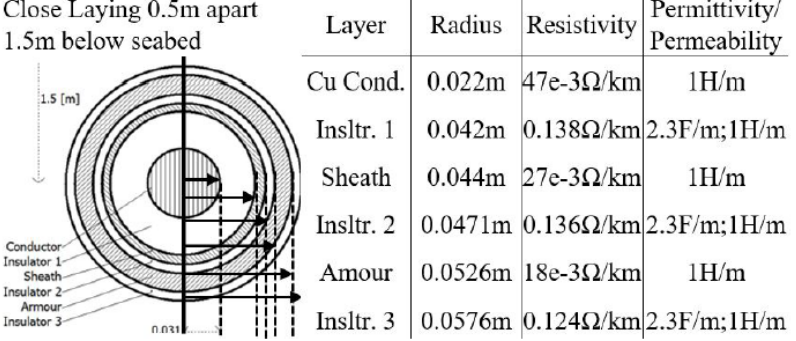
Figure 4. 200 km close laying ABB submarine cable